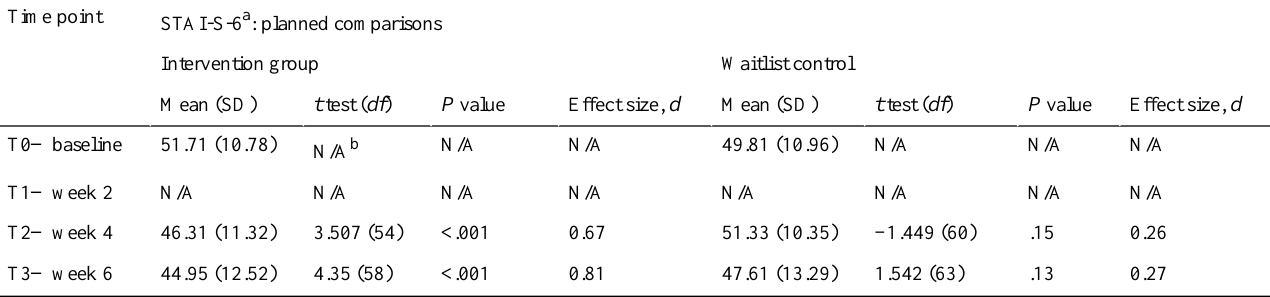
Table 3. Mean, SD, and planned comparisons on State-Trait Anxiety Inventory scores over the duration of the study (T0, T1, T2, and T3) in the intervention and waitlist control